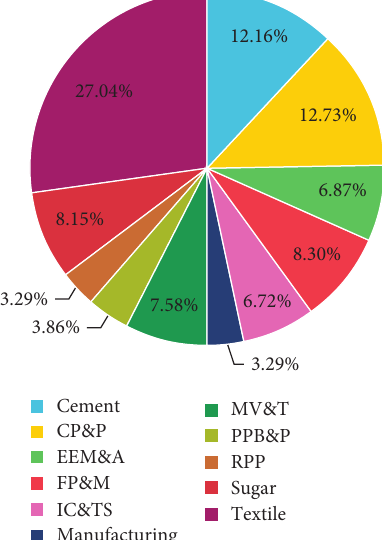
Figure 5: Decomposition of financial expertise (PhD degree) in equity